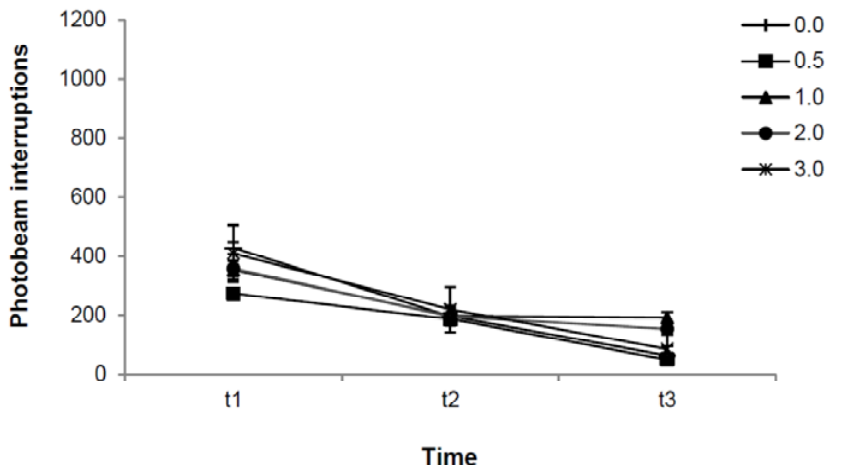
Figure 4. Effect of indanamide ( 3 ) on total motor activity. Data represent means (±SE) of photobeam interruptions during 60 (t1), 120 (t2) and 180 (t3) minutes after administration of 0.0, 0.5, 1.0, 2.0 and 3.0 mg/kg. ANOVA indicated that time but not indanamide 3 had a